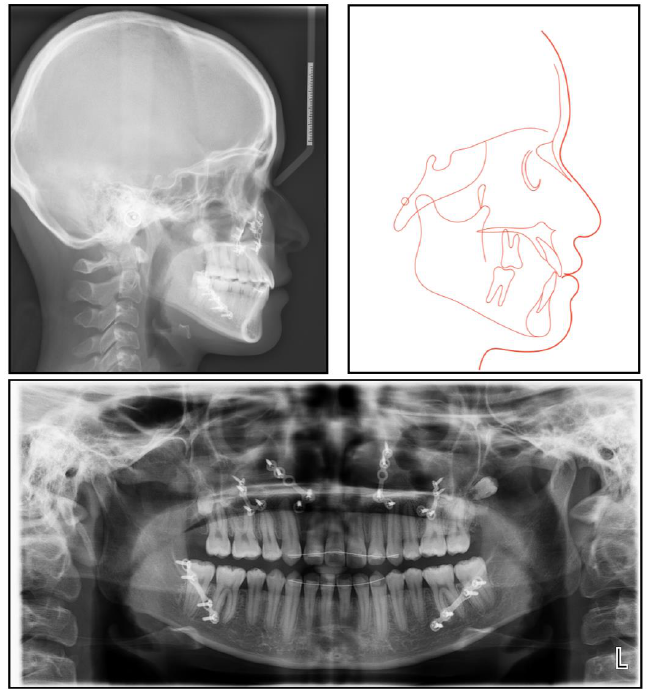
Figure 9. Posttreatment lateral cephalometric radiograph and tracing and a panoramic radiograph.